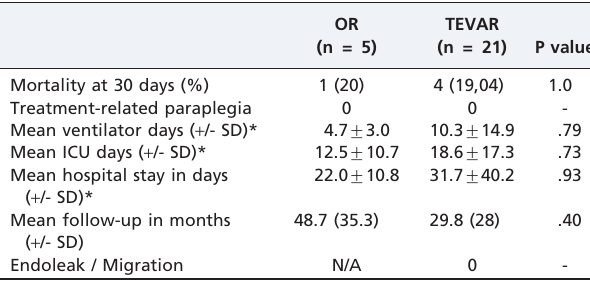
Table 3 - Outcomes.